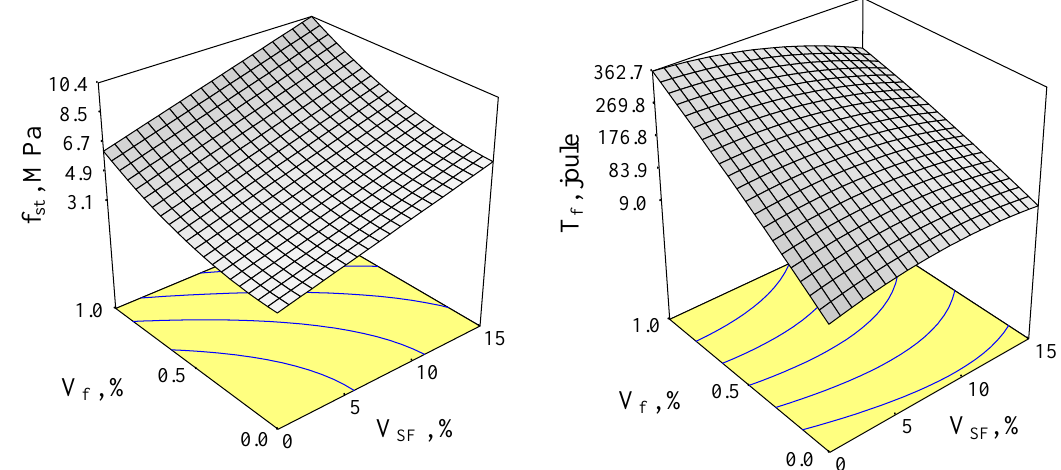
Figure 3. Response surfaces of f st and T for the fiber aspect ratio of 80. For an aspect ratio of 65, the correlation coefficients (R 2 ) for the model of splitting tensile strength ( f st ) and flexural toughness ( T f ) were found to be 0.90 and 0.94, respec- tively. Similarly, the correlation coefficients for the aspect ratio of 80 were 0.94 and 0.98, respectively. Correlation coefficients for each model obtained were quite high. The equa- tensile strengths and flexural toughness of SFRCs in the range of 0 – 1% steel fiber volume fraction and 0 – 15% silica fume content in similar studies.